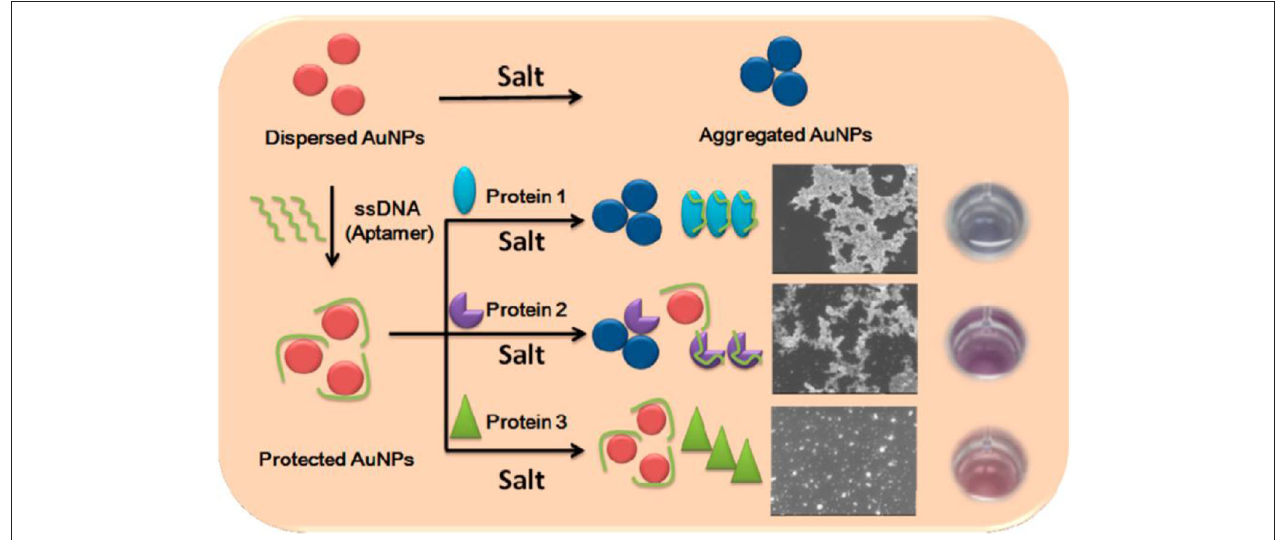
FIGURE 6 | Schematic representation of the sensing principle of the aptamer-based sensor array. Reprinted from Lu et al. (2013b) with permission.